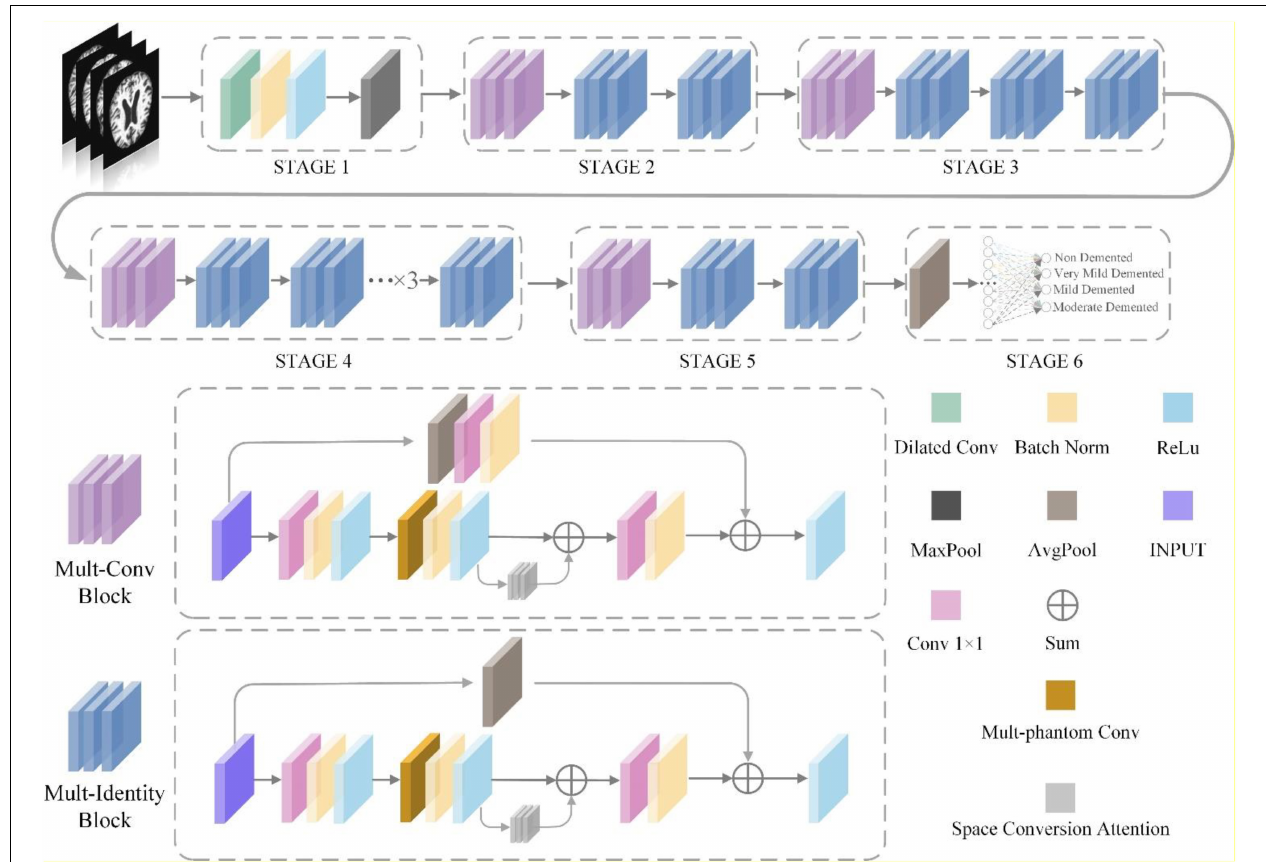
FIGURE 6 | The t overall architecture of the